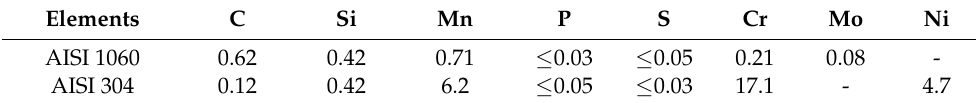
Table 1. Chemical composition (%) of the AISI 304 and AISI 1060 stainless